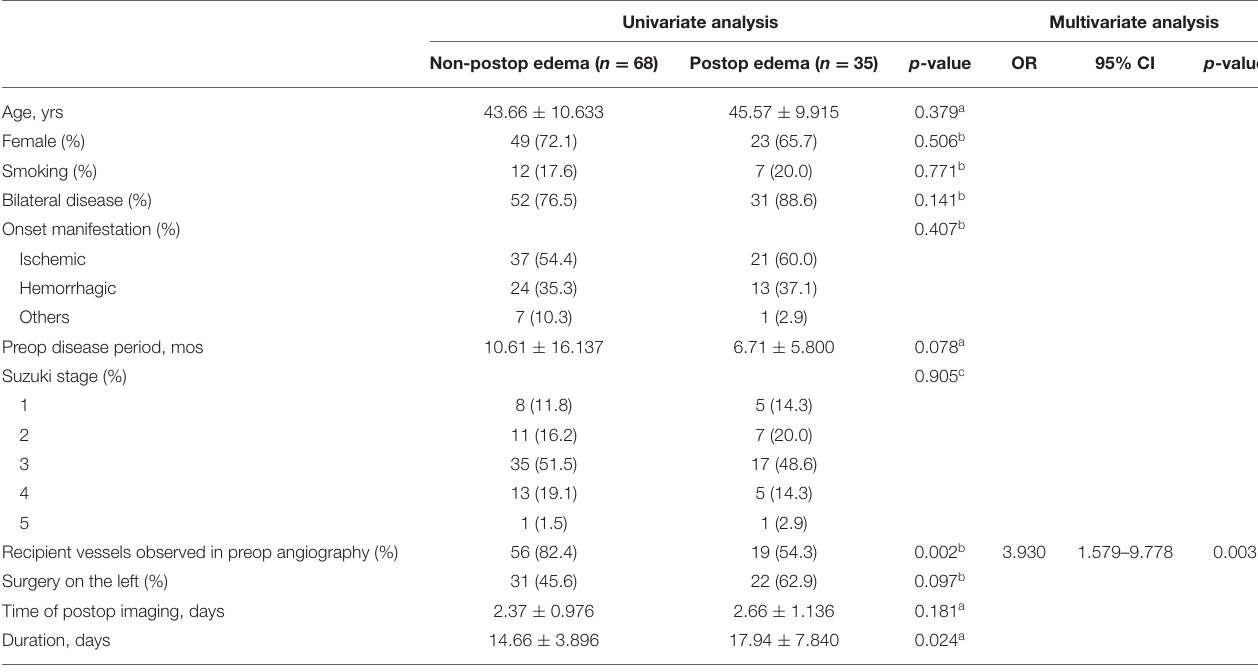
TABLE 2 | The factors related with postoperative cerebral edema in adults with moyamoya.